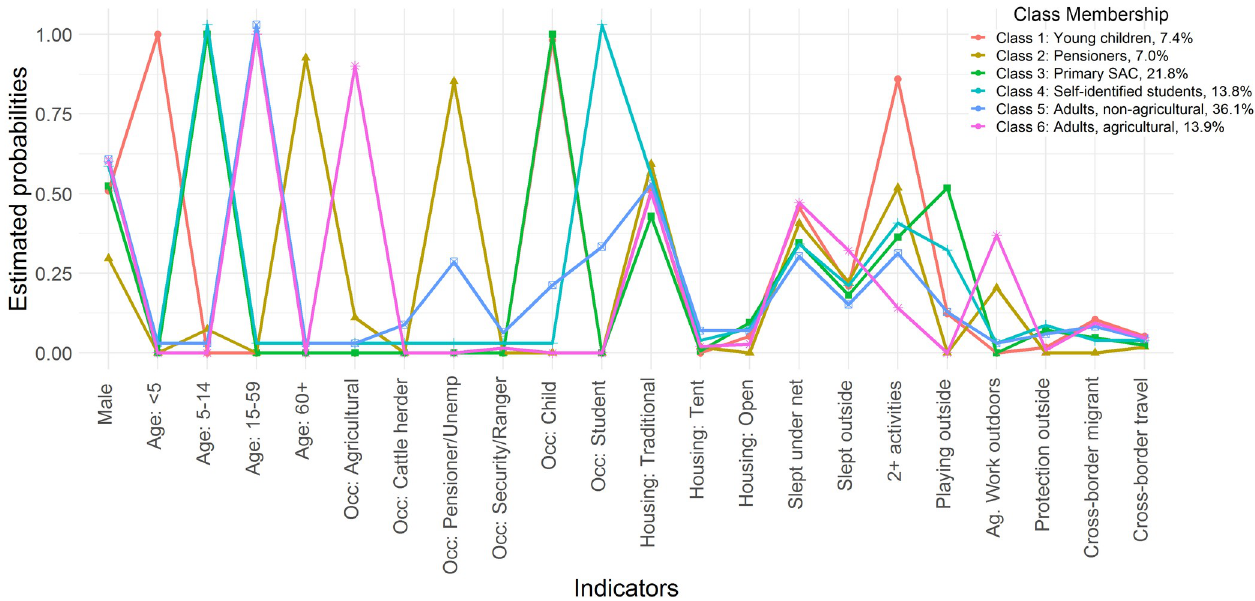
Fig 5. Profile plot of estimated indicator probabilities and latent class proportions for all six latent classes of malaria risk in a sample of malaria cases from Zambezi Region. The item-response probabilities represent the probability of a positive response on a variable, given membership in a given class.